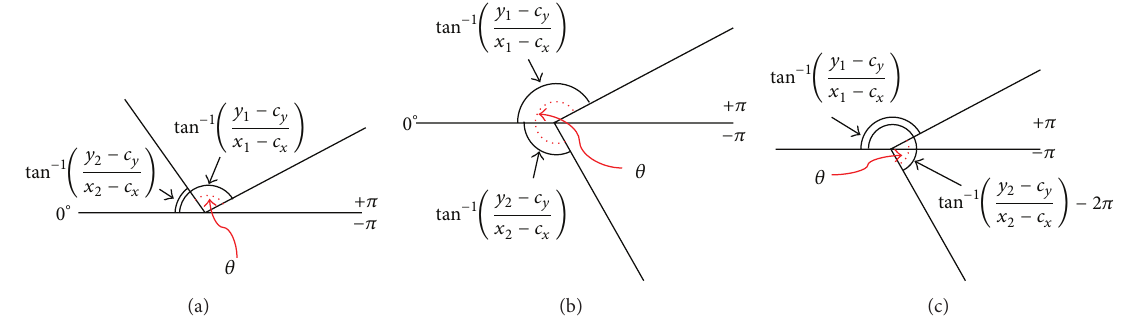
Figure 10: Angle calculation using three sequential points of the hand’s outline edge. (a) Obtaining angle in a normal case. (b) Obtaining the opposite angle in error case. (c) Compensating error case ( 𝜃 : calculated angle of three points at the intervals of five adjacent edge points).